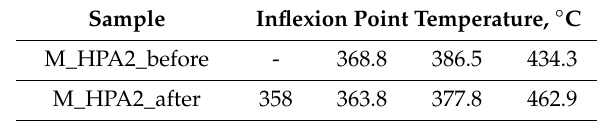
Table 5. Inflexion points of TG curves before and after